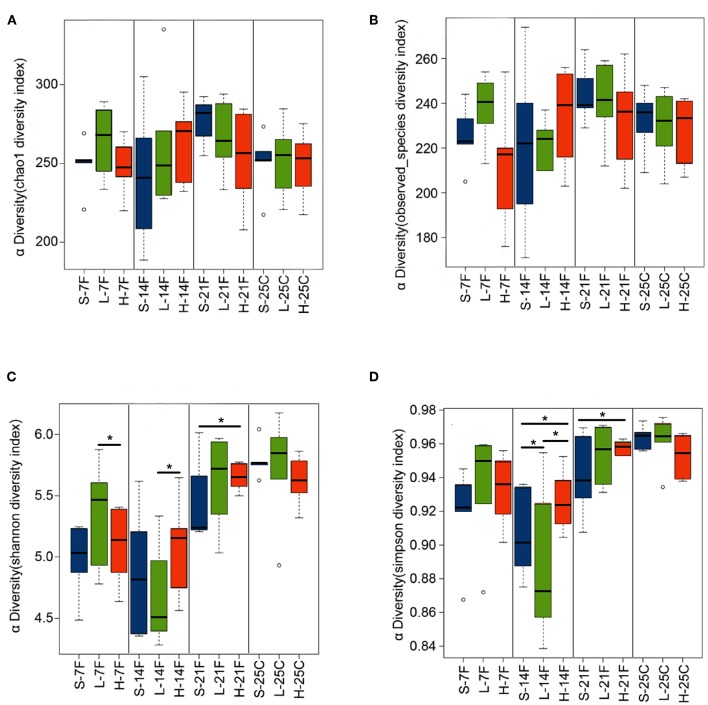
Barplots of α-diversity indexes in the treatment groups of saline, low, and high doses of spirulina at designated time points (day 7th, 14th, 21st, and 25th). (A) Chao1 index; (B) Observed species index; (C) Shannon index; (D) Simpson index. The difference of each α-diversity index was compared between individual treated samples within the same designated day by the Wilcoxon test with *p < 0.05 considered as statistically significant. In the x-axis label, S, L, and H represent the treatment of saline, low, and high doses of spirulina, respectively, and F and C represent feces and cecum, respectively.